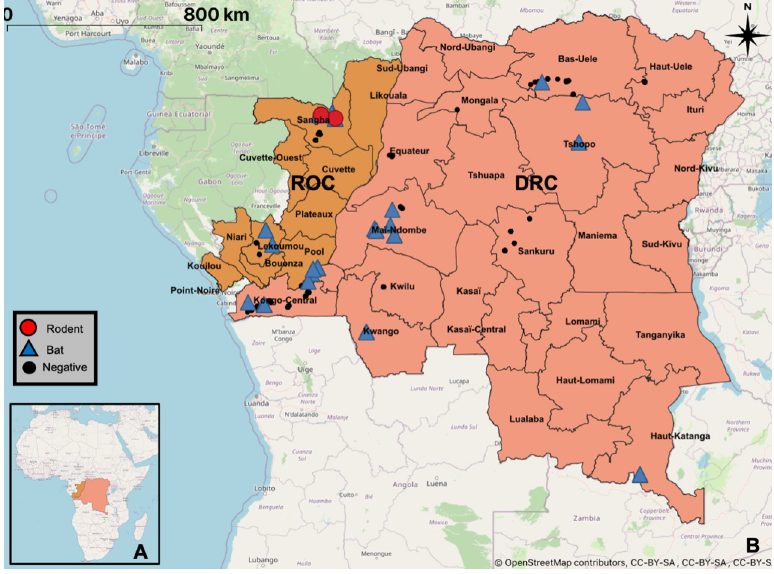
Fig 1. Sampling sites map. Geographical map indicating all sampling sites within the Republic of Congo and the Democratic Republic of the Congo. Locations where coronaviruses were detected are highlighted with blue triangles for bats and red circles for rodents. Sampling sites without viral RNA detection are marked by black dots (see also S1 Fig). Base map and data from OpenStreetMap and OpenStreetMap Foundation.